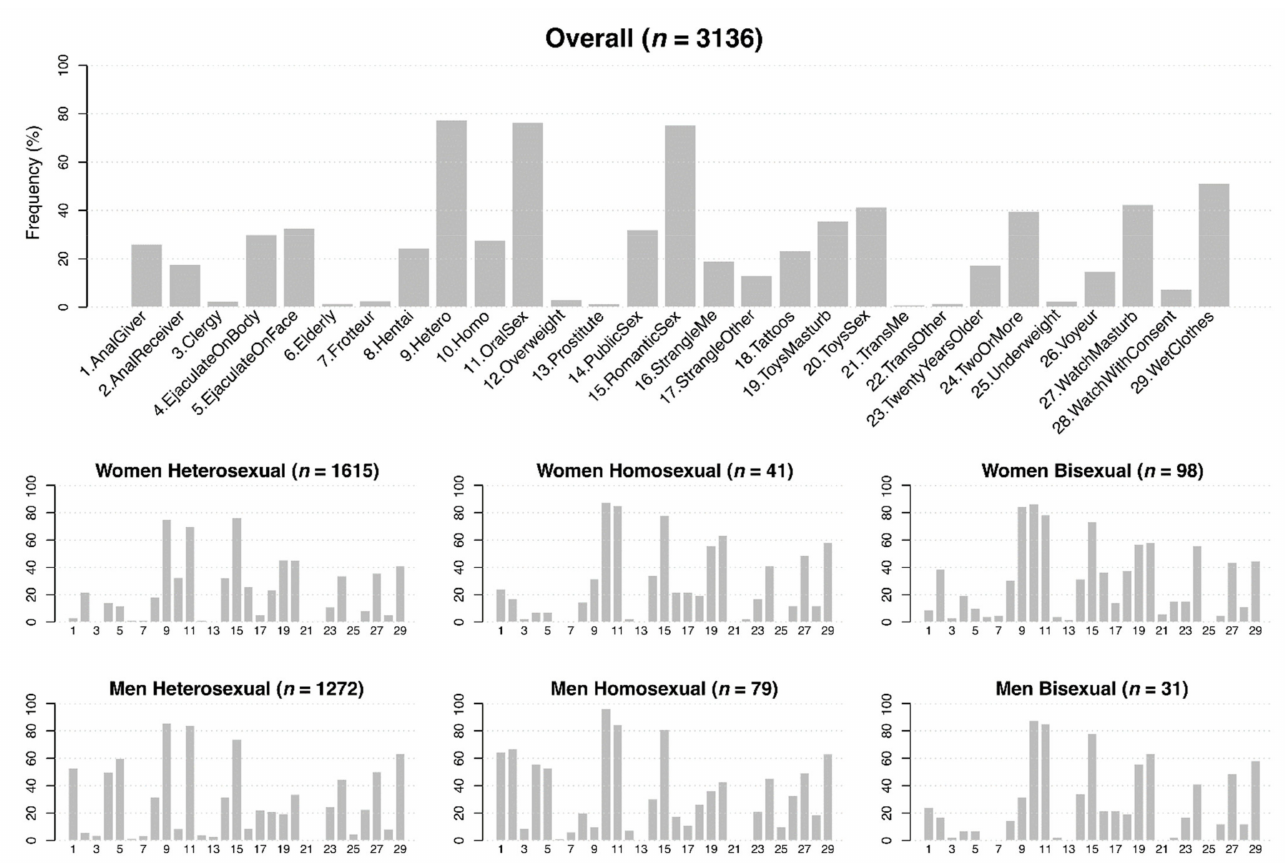
Figure 1. Prevalence of arousing sexual fantasies in the overall sample and